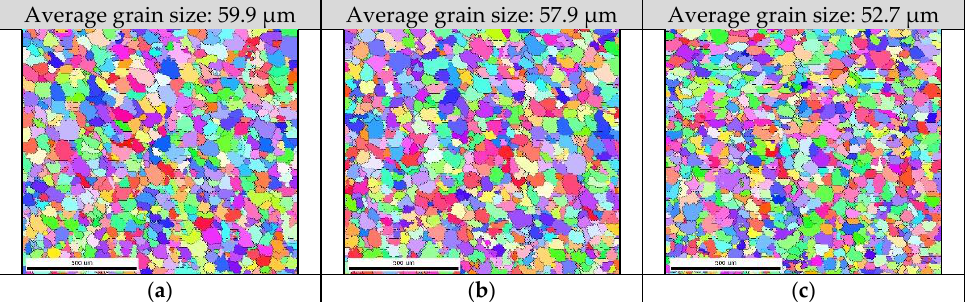
Figure 14. EBSD results for ( a ) one, ( b ) three, and ( c ) five repetitions. The specimens were prepared at a welding speed of 0.5 m/min and R EN of 0.5. Scale bar = 500 μm .